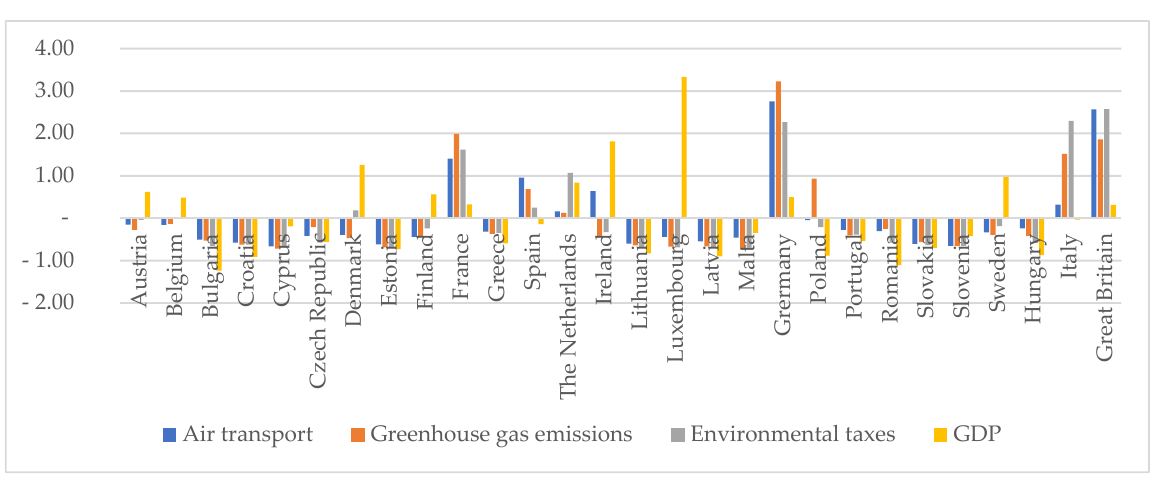
Figure A10. Distribution of European Union countries determined using Perkal index in 2018. Source: Reproduced from